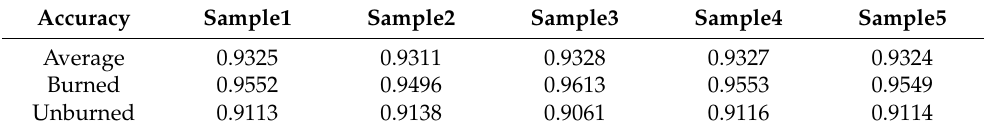
Table 2. Model accuracies by RF model.